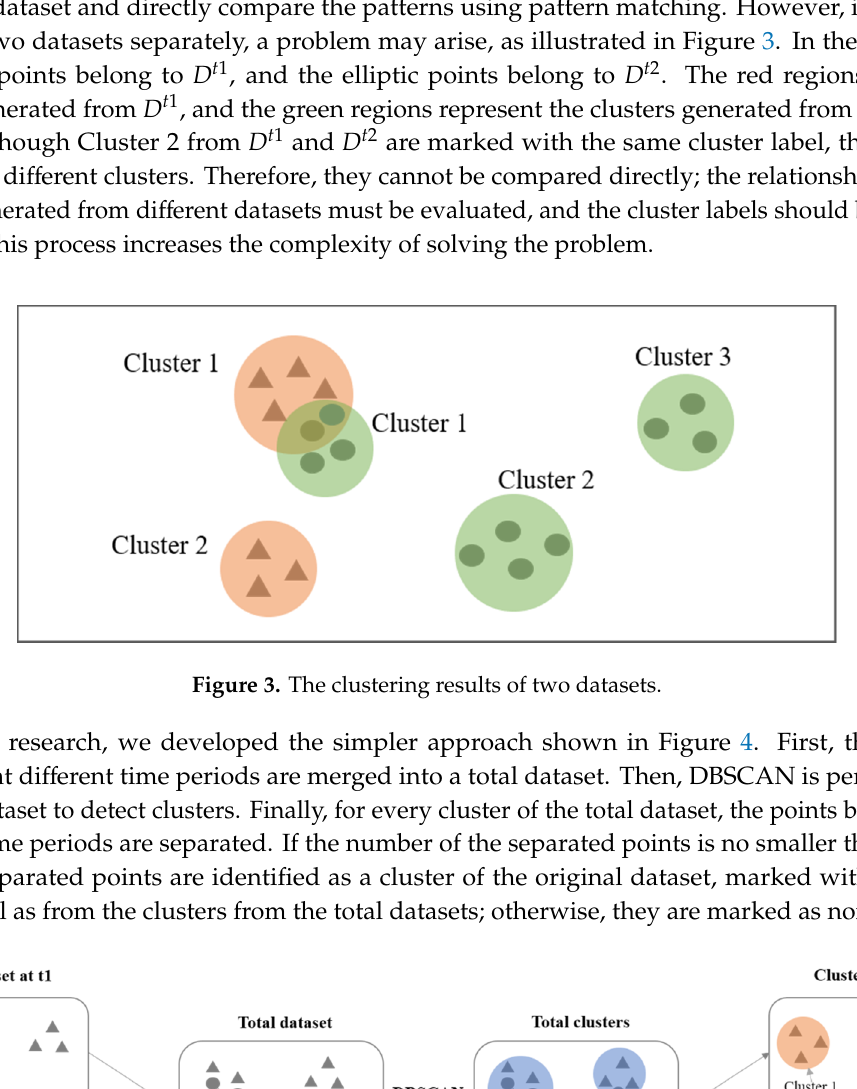
Algorithm 1 Pattern identification algorithm.